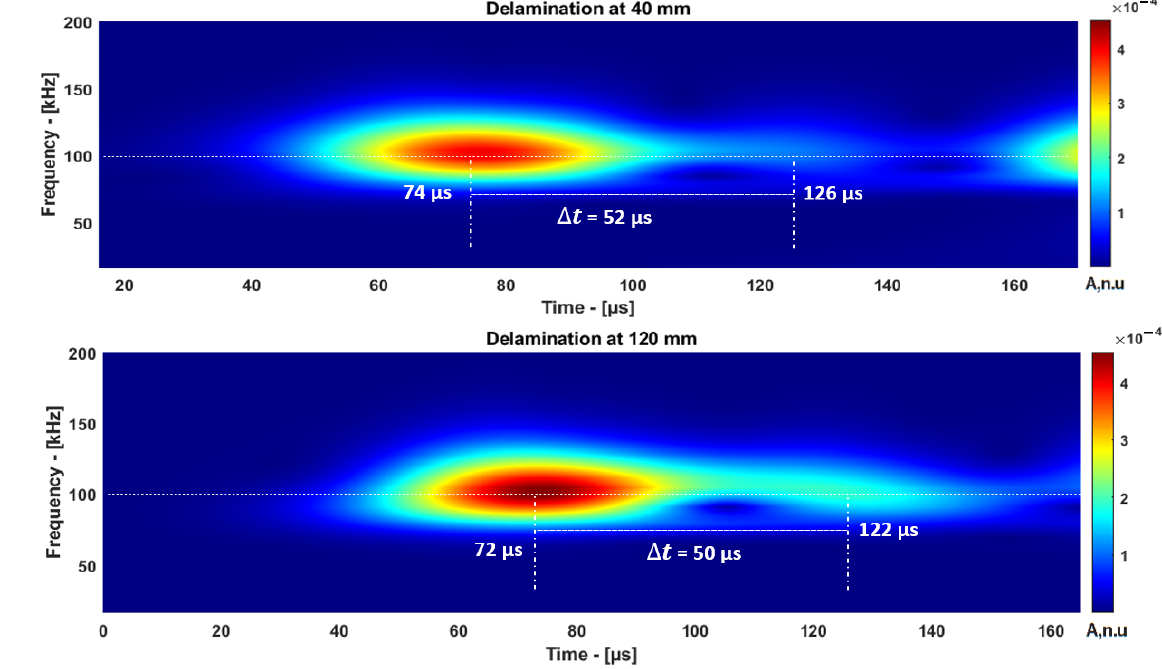
Table 6. The localization of delamination at 40 mm using CWT.